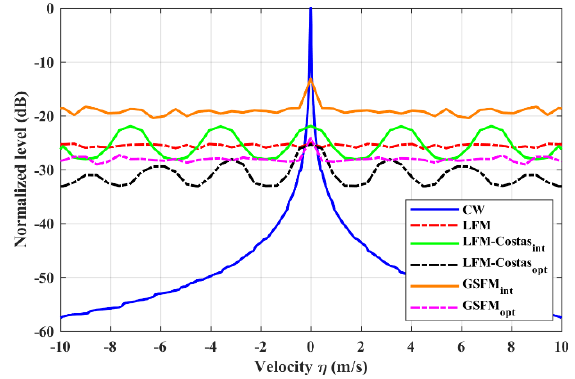
Figure 9. Q-functions of several continuous pulse trains.